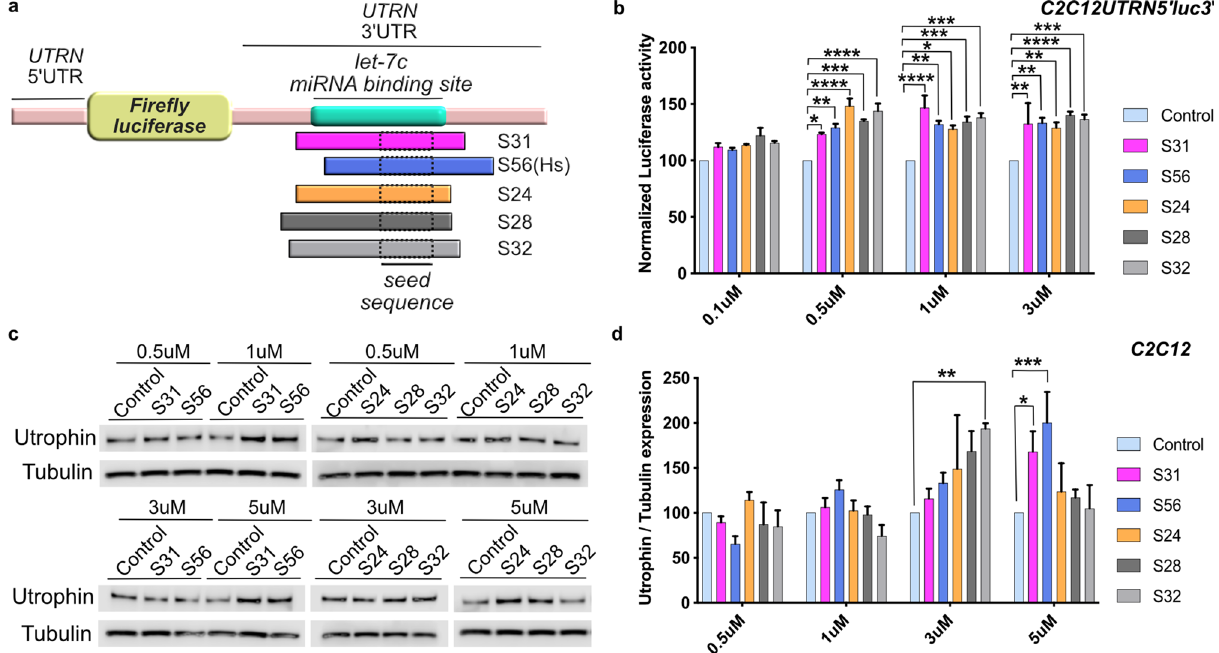
Figure 2. Let-7c PMO SBO upregulates utrophin expression in the C2C12 cell line. ( a ) Schematic diagram showing the relative position of the let-7c binding site (green) of five different let-7c PMO SBOs in UTRN 3 ′ UTR. ( b ) Luciferase expression in C2C12 UTRN 5 ′ luc3 ′ reporter cell line after treatment with 0.1 µM, 0.5 µM, 1 µM and 3 µM of control or five different let-7c PMO SBOs for 24 hrs. Data shown as percentage of normalized luciferase expression compared with control PMO treated cells (n = 3). ( c ) Endogenous utrophin expression in C2C12 cell line after treatment with 0.5 µM, 1 µM, 3 µM and 5 µM of control or five different let-7c PMO SBOs for 48 hrs. ( d ) Quantification of endogenous utrophin expression in C2C12 cell line shown as percentage of normalized utrophin expression compared with control PMO treated cells (n = 3). Each bar represents mean ± SEM. Statistical analysis performed by Two-way ANOVA Tukey’s multiple comparisons test * p < 0.1, ** p < 0.01, *** p < 0.001, **** p <